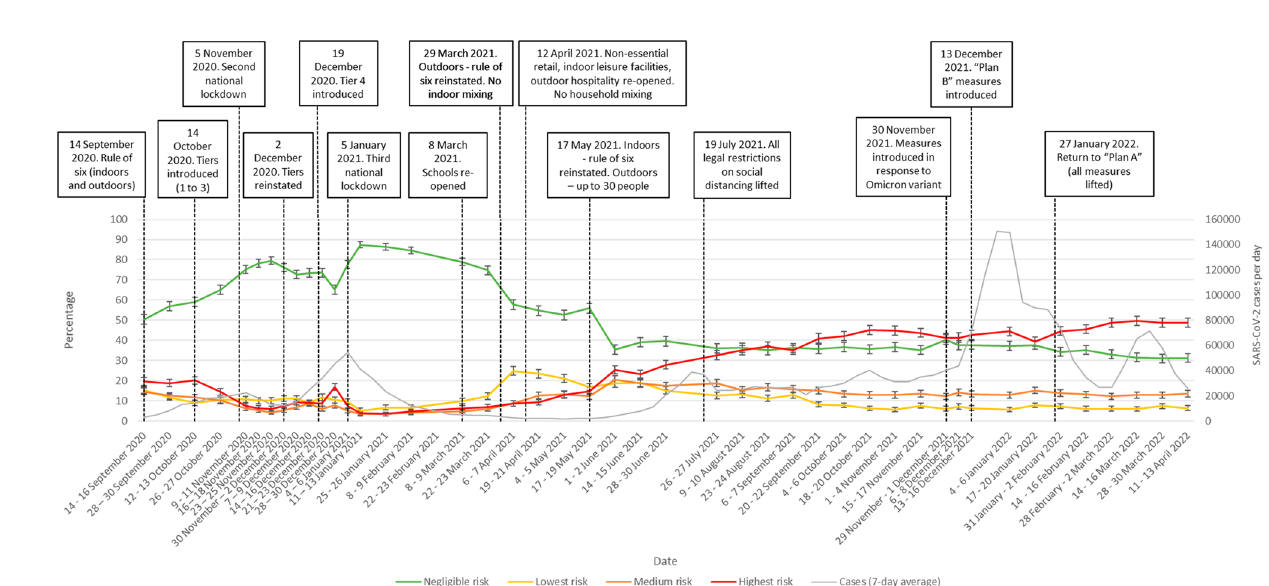
Figure 2. Pattern of risky social mixing between September 2020 and April 2022. Error bars are 95% confidence intervals. The grey line shows the number of new SARS-CoV-2 cases per day (7-day average) in England 19 . Case rates from April 2022 are an underestimate as only selected people were eligible for testing.